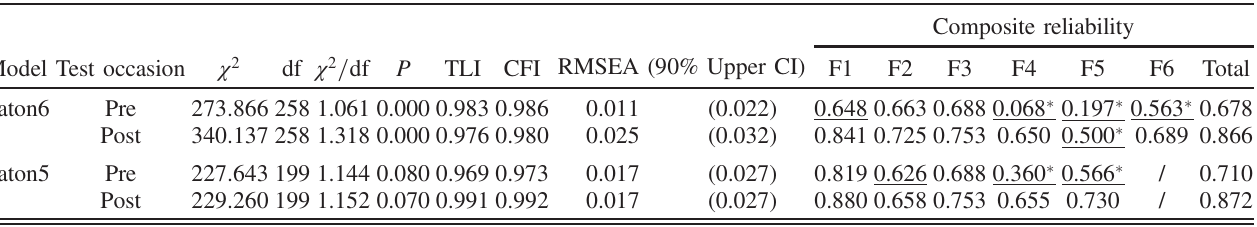
TABLE VI. Fit statistics for the two models of CSEM applied to the pre- and post-test datasets separately. The reliability estimates for the subscales identified by different models and the whole FCI were computed using CR. Values of CR below the minimally acceptable level (0.65) were underlined, and the unacceptable values of CR ( < 0 . 60 ) were further marked with an asterisk (*).